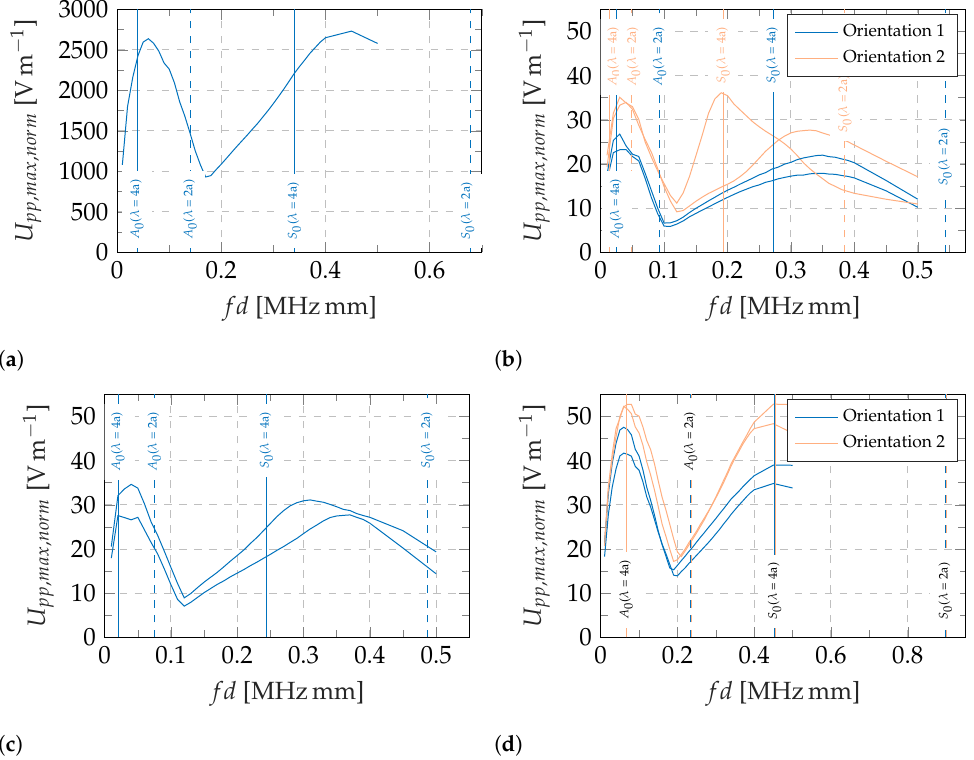
Figure 6. Experimentally determined peak-to-peak voltages for different sensor types, shapes, and orientations under GUW excitation in a 2mm aluminum plate, analytically calculated amplitude maxima (solid vertical lines) and minima (dashed vertical lines) based on estimated effective sensor lengths in wave propagation direction, cf. Figure 2 and Equations (2) and (3). ( a ) Commercial solid piezoceramic sensor, Figure 2b. ( b ) Piezocomposite sensor: square, Figure 2c,d. ( c ) Piezocomposite sensor: circle, Figure 2e. ( d ) Piezocomposite sensor: annulus segment, Figure